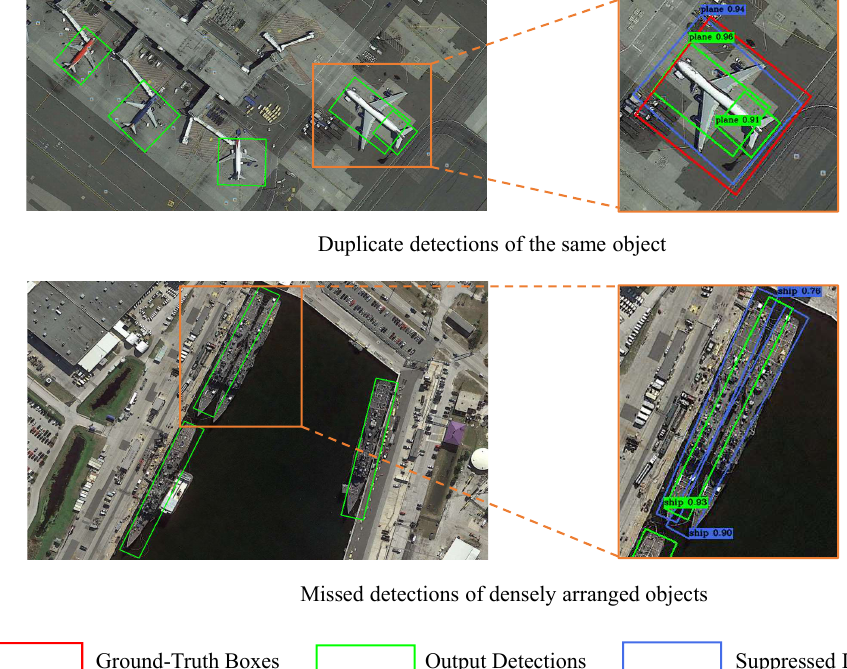
Figure 1. Visualization of the duplicate detections and missed detections in aerial images. Moreover, dense object detection in aerial images suffers from missed detections due to dense label assignment. The bottom of Figure 1 shows the example of missed detection of densely arranged ships. The output detection box (green box with score of 0.93) with poor localization accuracy suppresses the more accurate predictions (blue boxes with scores of 0.90 and 0.76), leading to missed detection of ships. In the above cases, dense positive samples lead to high-overlapping detections. However, the corresponding classification scores are not effective in distinguishing their localization accuracy, thereby resulting in poor detection